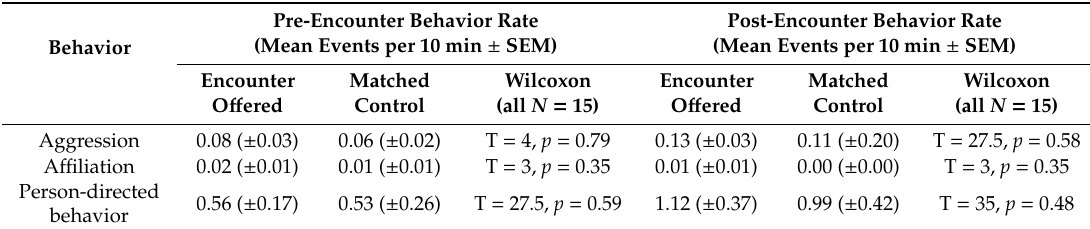
Table 3. Mean behavior rates (events / 10 min) for aggression and a ffi liation during pre-encounter, post-encounter, and matched control conditions and sample sizes, Wilcoxon signed-rank T- and p